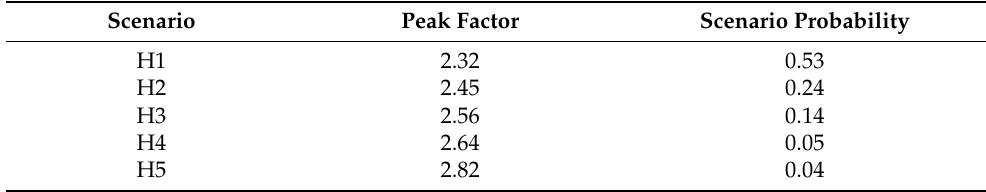
Table 4. Example of 5 water demand scenarios and corresponding probabilities estimated based on the measurements at the supply area of Wassenaar, The Netherlands (Dunea).